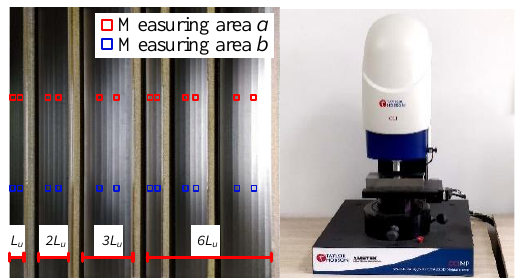
Figure 12. Measuring surface roughness.